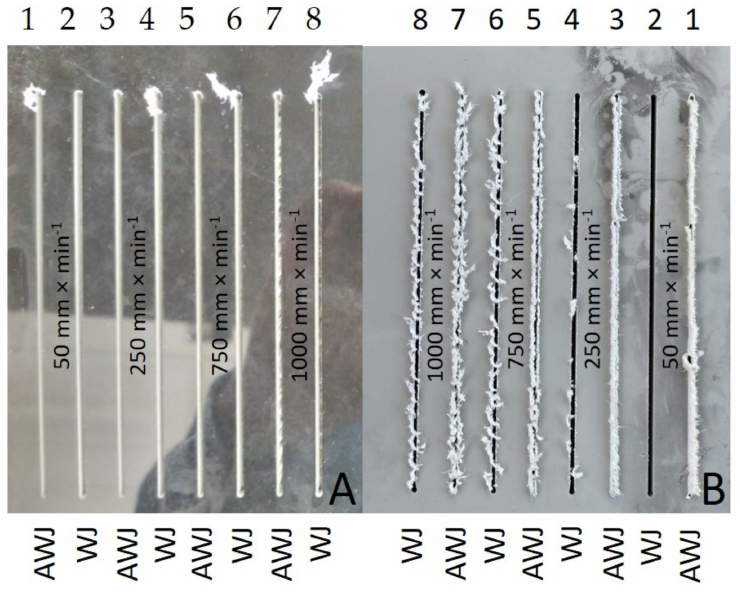
Figure 12. Cutting gaps in PP + MOBIHEL: ( A ) WJ and AWJ inlet; ( B ) WJ and AWJ outlet. Figure 14 shows an image analysis of the inlet and outlet waterjet sections of PP +